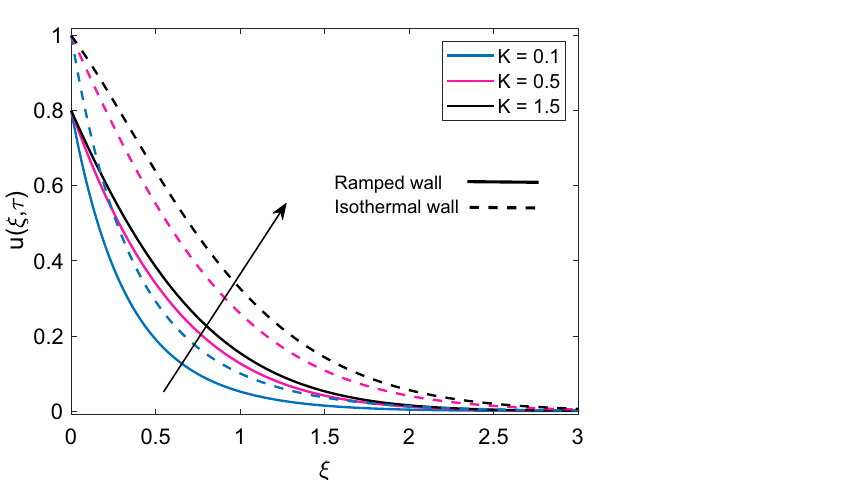
Figure 9. Velocity distribution [Eq. (39)] for various values of Gr when M = 2.0 , K = 0.5 , Nr = 0.5 , φ = 0.1 and Q = 0.5 .